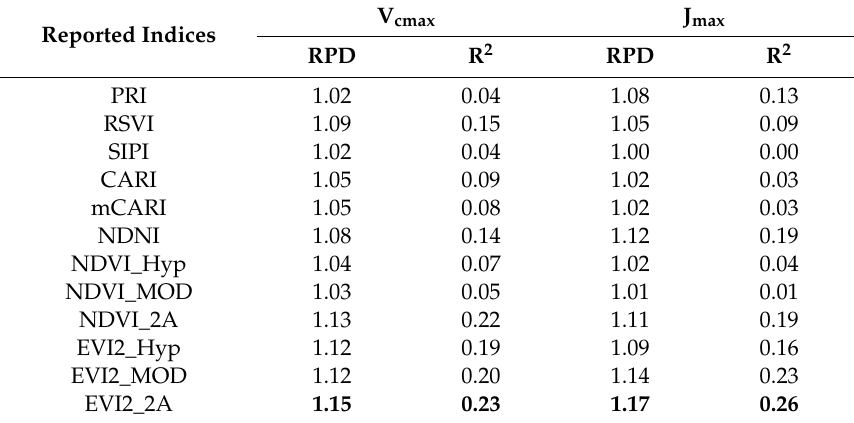
Table 4. Result of reported indices screening based on original reflectance spectra.